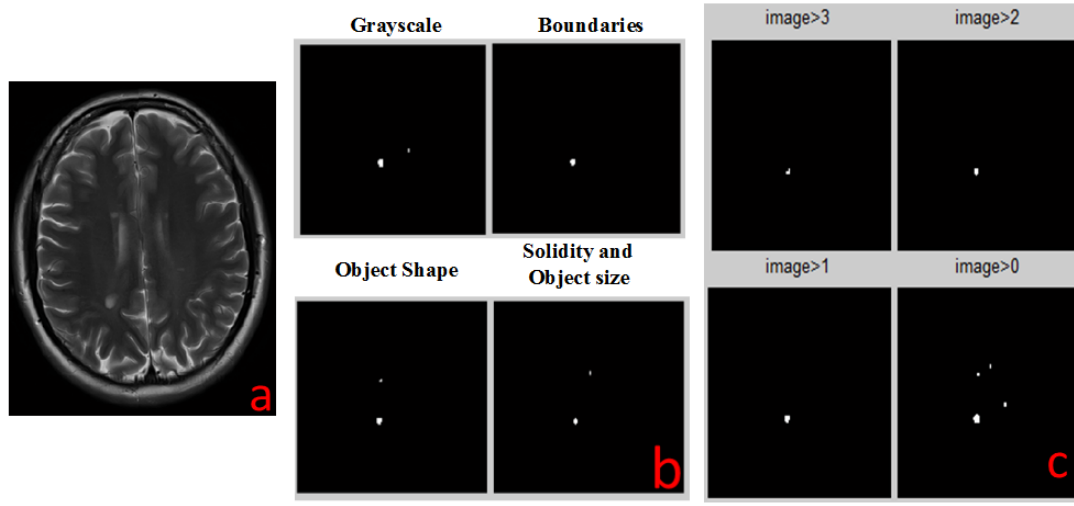
Figure 6. MS detection for image with T2_TSE type: ( a ) original Image; ( b ) results of all detection algorithms; ( c ) combination of all detection results, displaying pixels with value greater than a threshold value (see titles). The value of each pixel denotes the number of algorithms (out of 4) that detected this pixel as part of a positive suspected MS lesion.